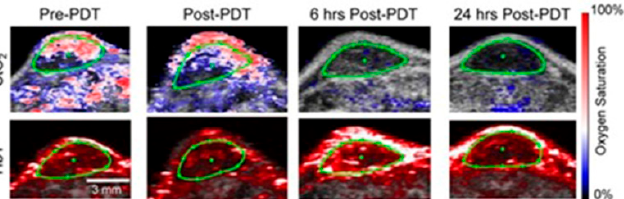
Figure 6. Combined ultrasound and photoacoustic images of responders in 1 h post-injection of photosensitizer before and after (immediate, 6 h, and 24 h) photodynamic therapy (PDT). ( Top row ) Ultrasound image in grayscale overlaid with oxygen saturation (StO 2 ) map where blue and red represent hypoxic and oxygenated regions, respectively. ( Bottom row ) Ultrasound image in grayscale overlaid with total hemoglobin image (HbT). The green circle indicates the tumor region identified using ultrasound image. Adapted with permission from Mallidi, S.; Watanabe, K.; Timerman, D.; Schoenfeld, D.; Hasan, T. Prediction of tumor recurrence and therapy monitoring using ultrasound- guided photoacoustic imaging. Theranostics , 2015 , 5 , 289 [250].